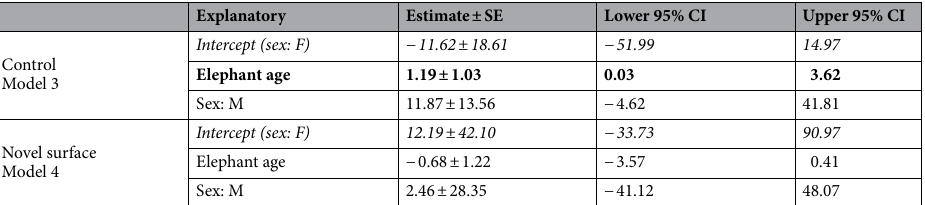
Table 3. Bayesian regression models analysing elephant success in relation to their age and sex (M = males, F = females) depending on the task (control—Model 3, N = 52; novel surface – Model 4, N = 42). All models included elephant identity nested in the date as random factors. Priors were automatically set by the brms function. Bold = Significant effects (CI’s do not encompass 0), italic = tendency